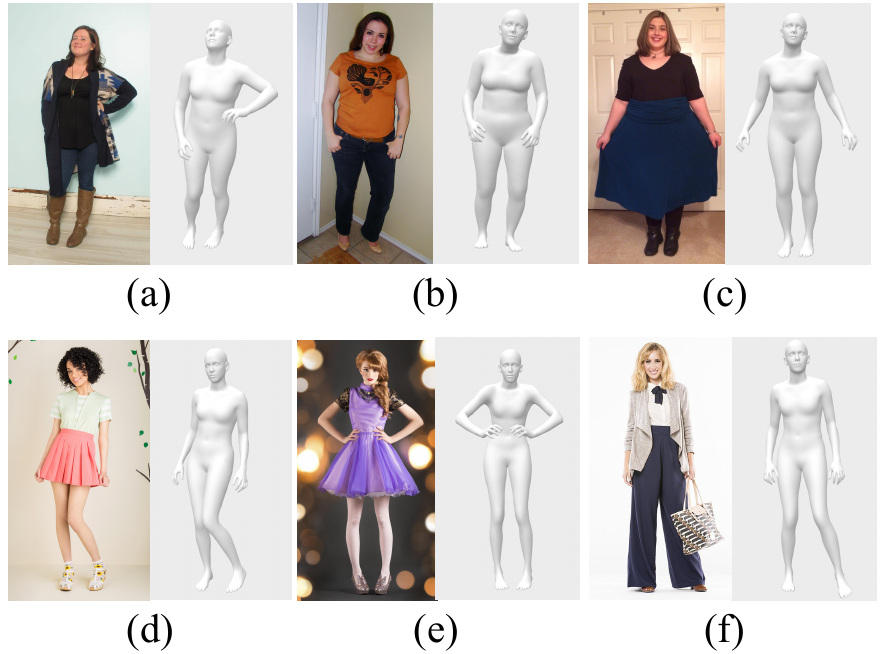
Figure 6. Meshes reconstructed by SMPLify-X for six people of different body types randomly selected from Street2Shop dataset. Subfigures ( a – c ) show some curvy people, while subfigures ( d – f ) show some slender